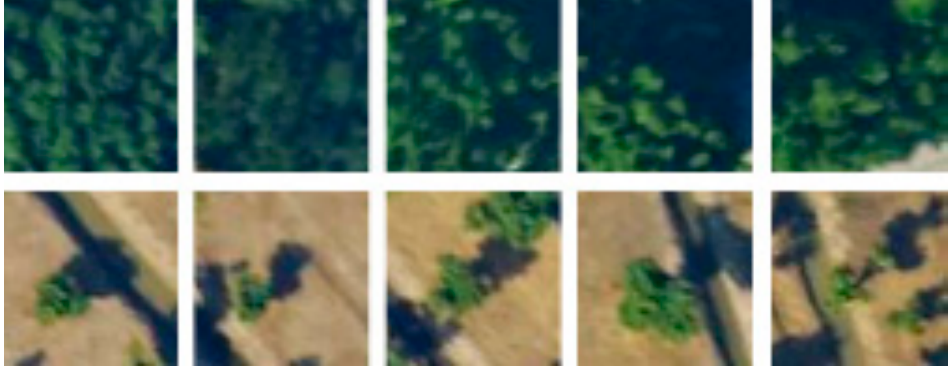
Figure 8. Tree patch samples over different image perspectives or light conditions. The first row is samples of banyan tree, while the second row is sakura tree.